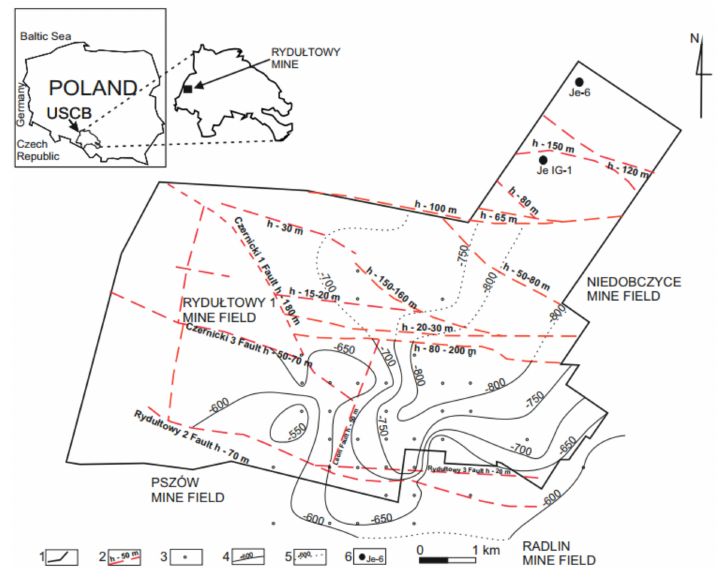
Figure 3. Top of the methane seams with G > 4.5 m 3 /Mg coal daf against the background of the tectonics of the research area (modified after Rydułtowy mine archive materials): 1—boundary of the Rydułtowy mine field, 2—fault with the displacement value, 3—estimation point of the top of the methane seams, 4—line of the top of the methane seams (m above sea level), 5—presumed line of the top of the methane seams, 6—surface bore